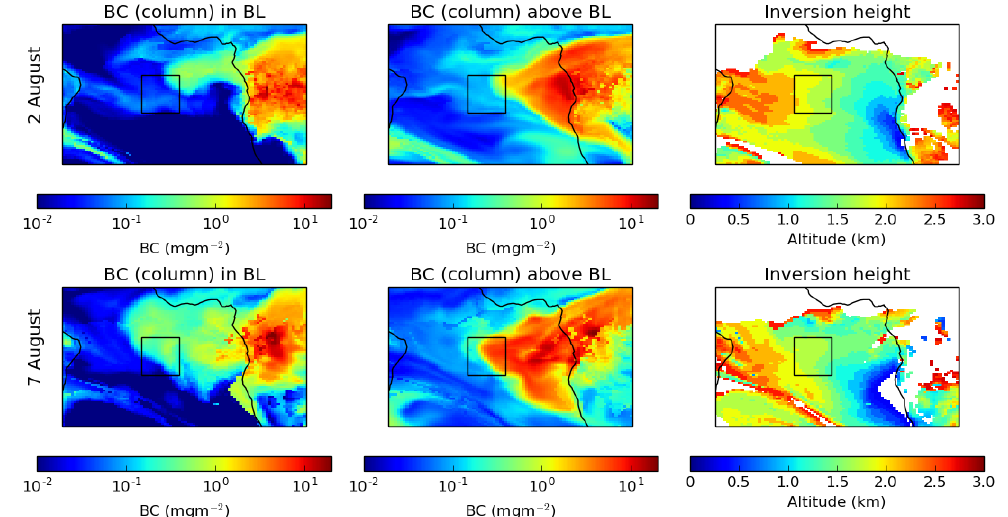
Figure 2. Black carbon (BC) column mass above and below the inversion (or above and below 1300m altitude, if a clear inversion could not be diagnosed) in the global model on 2 and 7 August, and the inversion height on these days. Where 1300m altitude is used because there is no inversion, or where the inversion height is over 2800m above the surface, the right-hand plots are white. The marked square is the domain of the regional model.